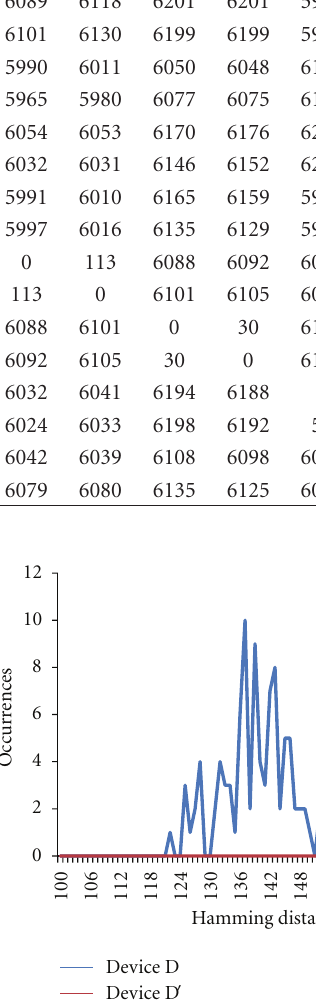
Figure 7: Enlarged presentation of the Hamming distance distribu- tion of T D relative to ρ D and ρ T = X , ... , τ 1000 )) device each. X X